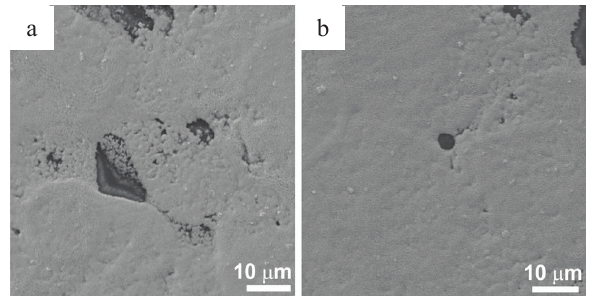
Fig. 3 – SEM image of PAA-AgNP surface after sintering a) at room temperature; and b) at 140 °C for 20 min